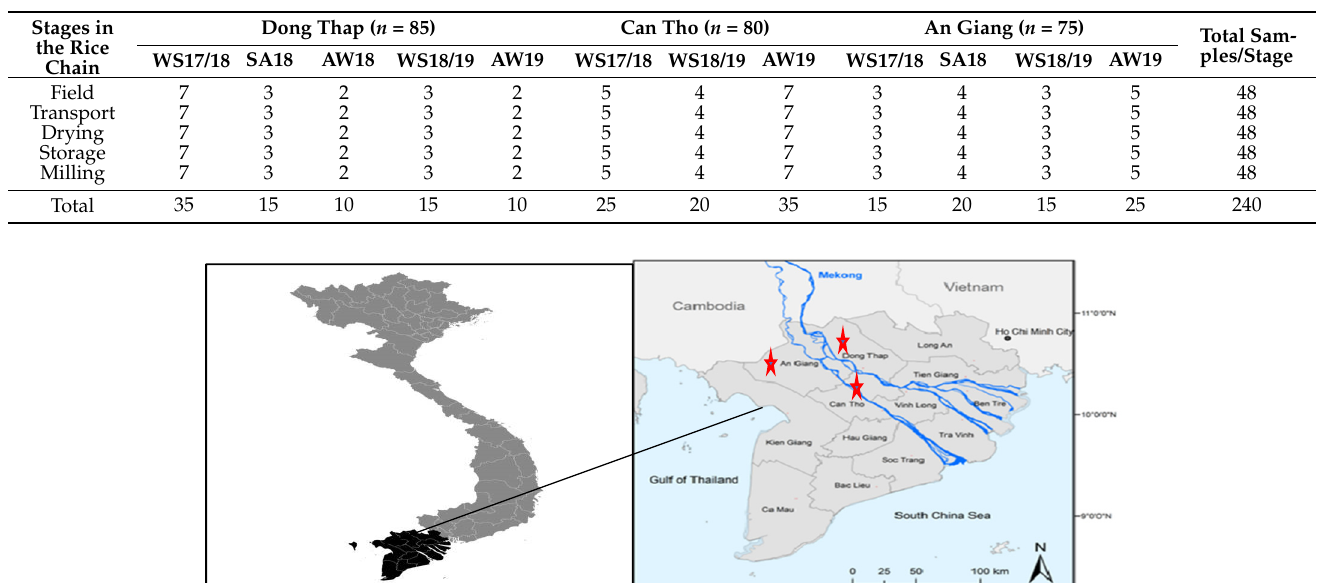
Table 1. Sampling plan ( n = 240), distributed over the crop seasons (WS—winter–spring; SA—summer–autumn; AW— autumn–winter) and three growing regions (Dong Thap, Can Tho, and An Giang) along the Mekong Delta rice chain between 2017 and 2019.